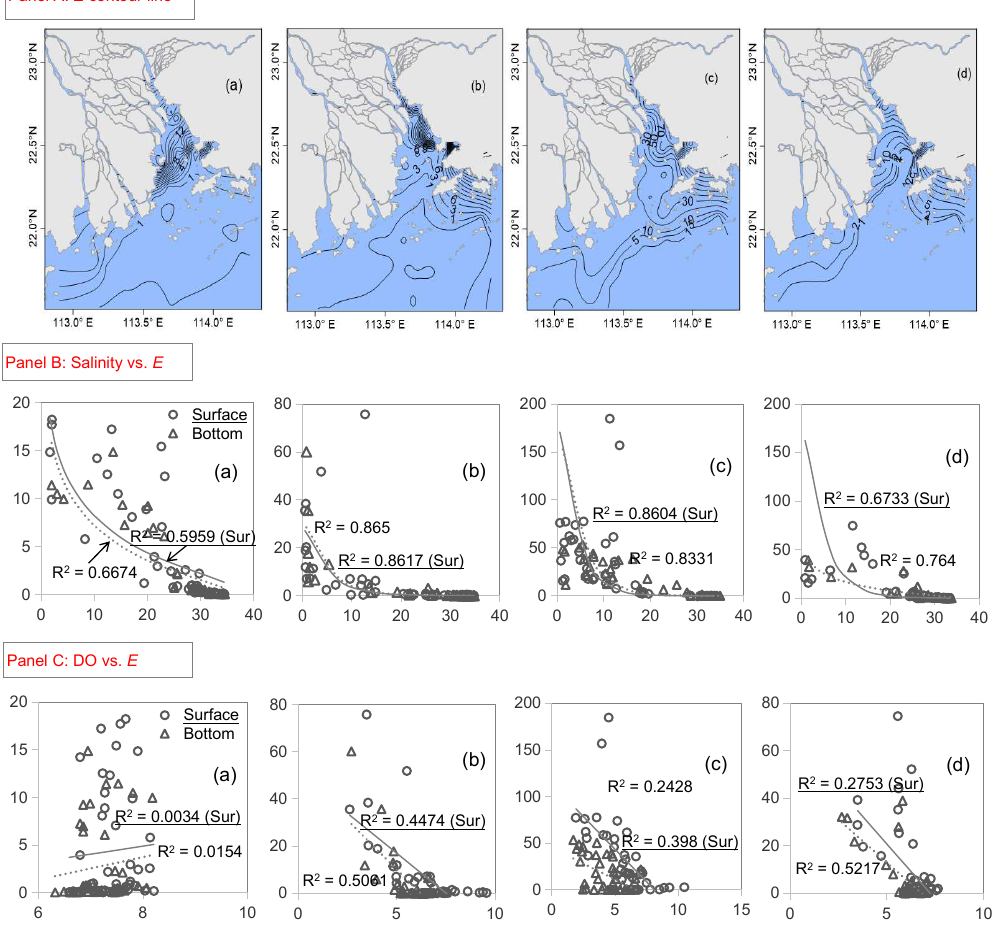
Panel A: E contour line